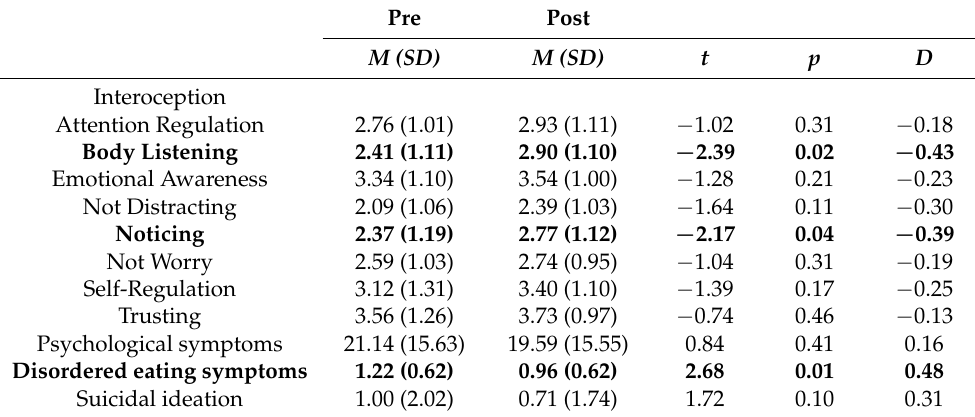
Table 2 for a summary of results. Table 2. Study 3 paired t -test results of Reconnecting to Internal Sensations and Experiences interven- tion among participants who completed the pre and post assessments ( n =